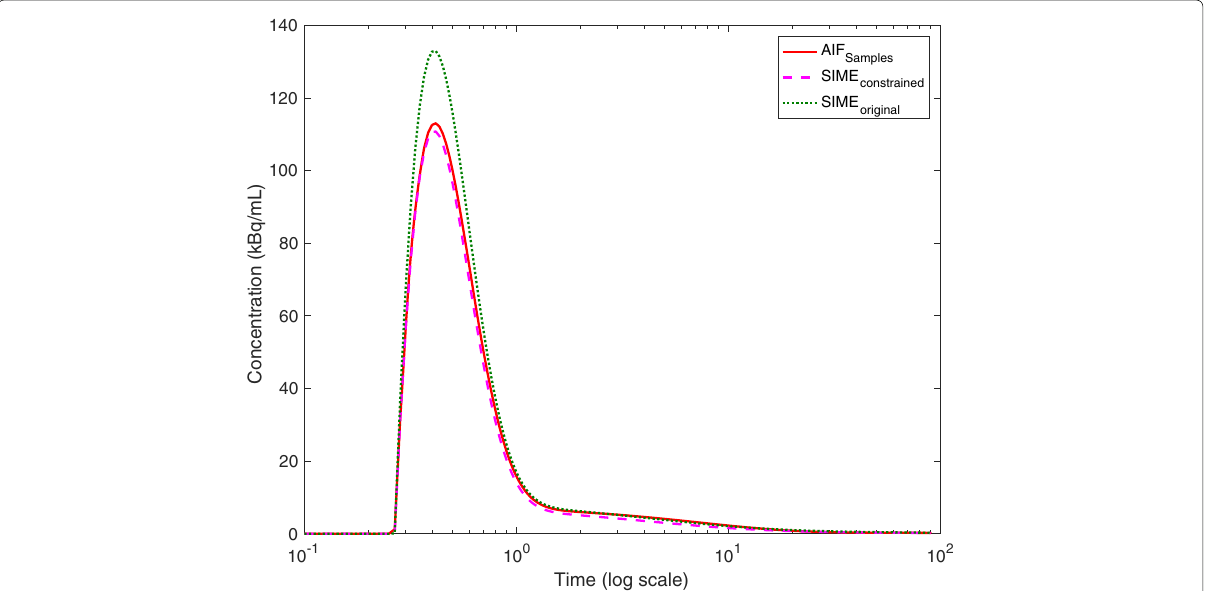
Fig. 5 AIFs derived using SIME original , SIME constrained and AIF samples plotted together for one subject. The x -axis is set to log scale to display curve peaks and tails